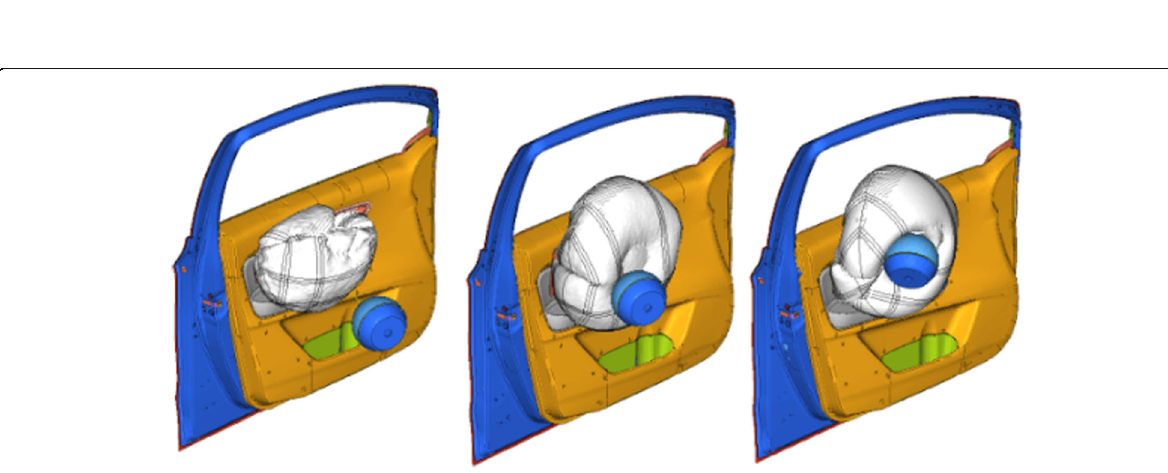
Fig. 16 The rider-airbag-car door collision process with the airbag protection at the opening angle of 60°